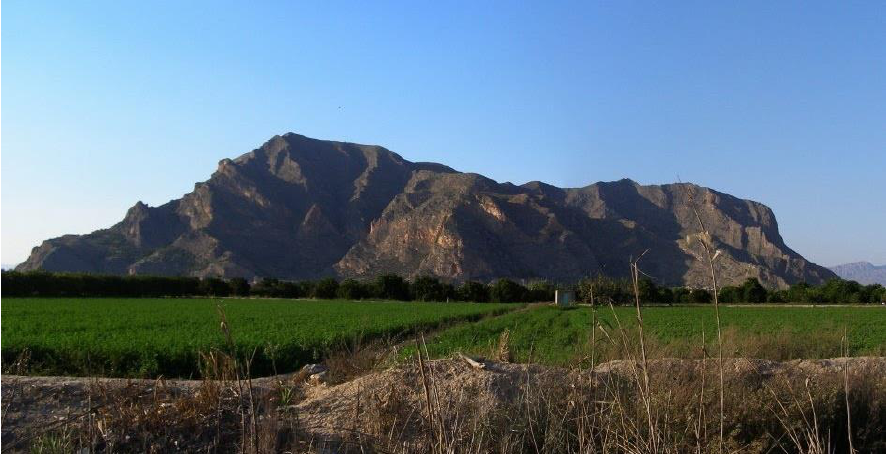
Figure 3. Agricultural plots in the floodplain contrasting with nude rock mountain in the Huerta de la Vega Baja. Author: J.